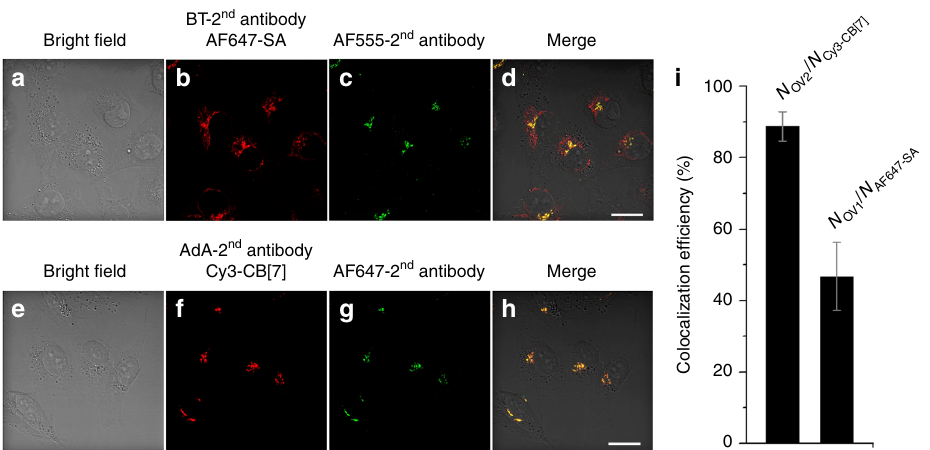
Fig. 2 Visualization of Golgi using SA – BT and CB[7]-AdA. Confocal laser scanning microscopy images of Golgin97 monoclonal antibody treated MCF-7 cells a – d after treatment of BT-labeled secondary antibody with AF647-SA and AF555-secondary antibody, and e - h after treatment of AdA-labeled secondary antibody with Cy3-CB[7] and AF647-secondary antibody, scale bar = 20 μ m. i A bar graph of colocalization ef fi ciency of fl uorescence signals between AF647-SA and AF555-secondary antibody, and Cy3-CB[7] and AF647-secondary antibody. The bar represents mean ± s.d. (see Methods for calculation of the colocalization ef fi ciency and Supplementary Figure 5 for magni fi cation of cells in Fig.